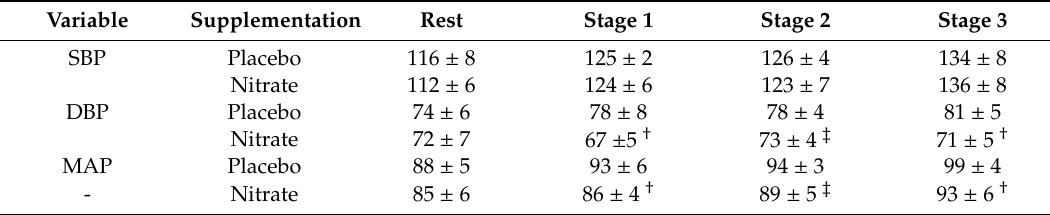
Table 3. Blood Pressure Response at Rest and During Submaximal